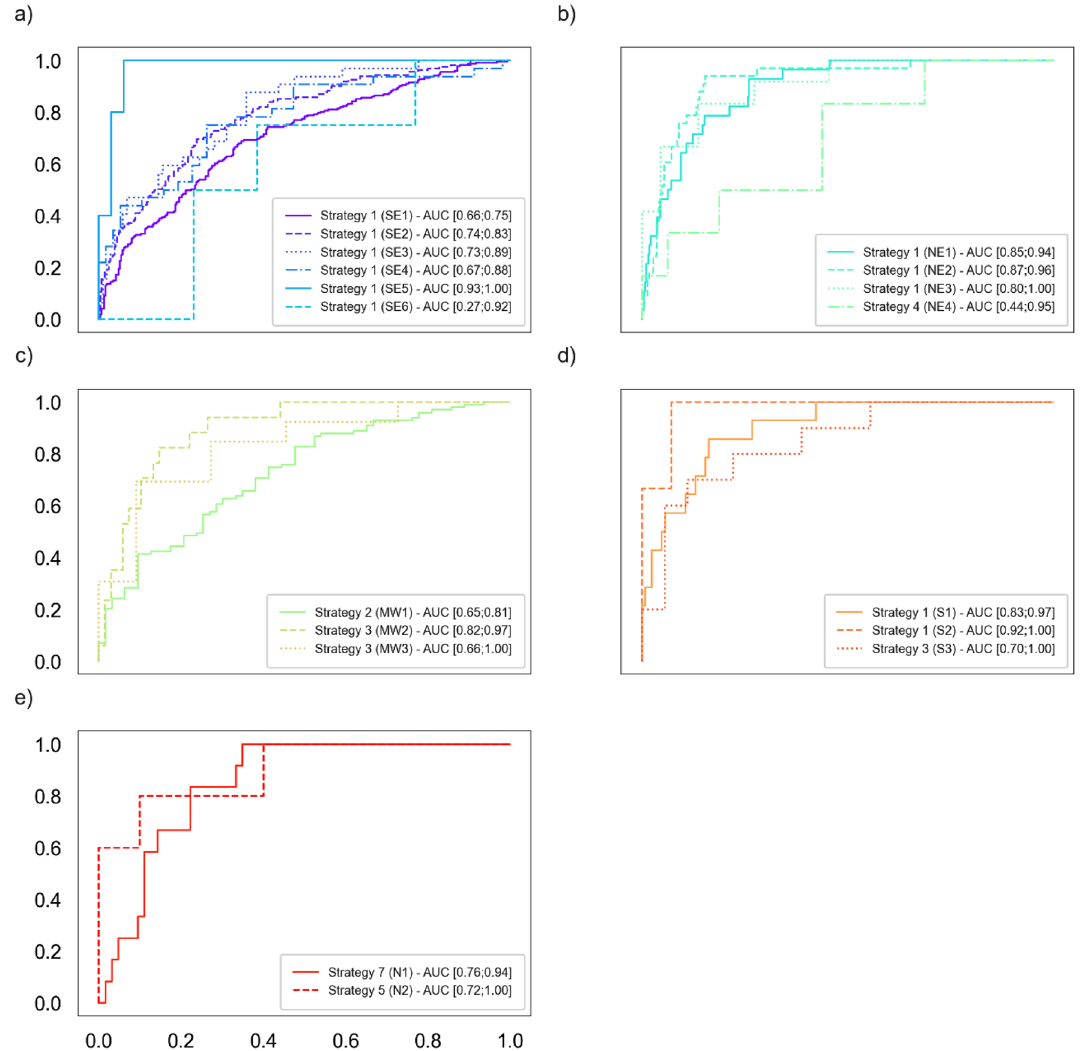
Figure 2. AUROCs of the winning strategy per region. ( a ) Southeast, ( b ) Northeast, ( c ) Midwest, ( d ) South, ( e ) North.